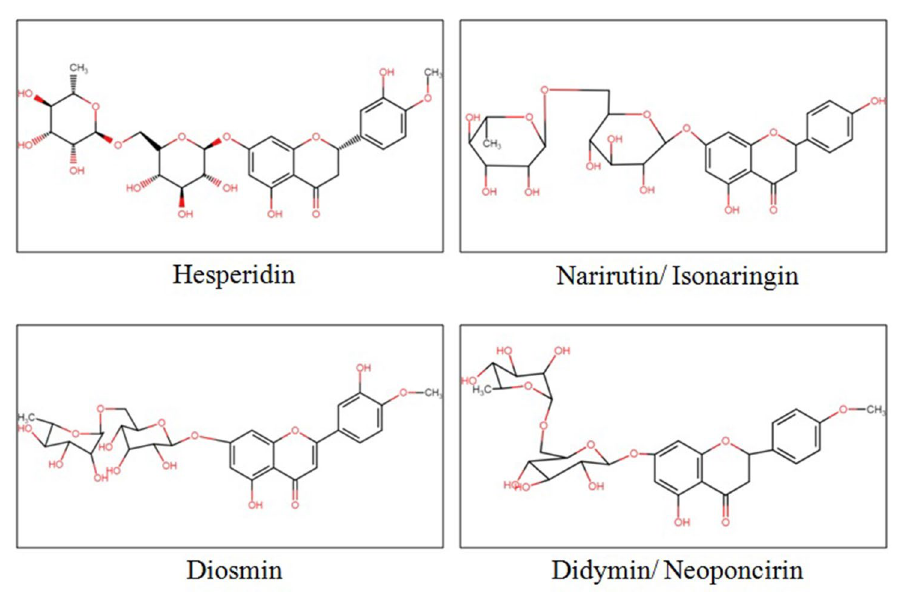
Figure 3. Chemical structure of citrus flavonoids (ChemIDPlus database) 20